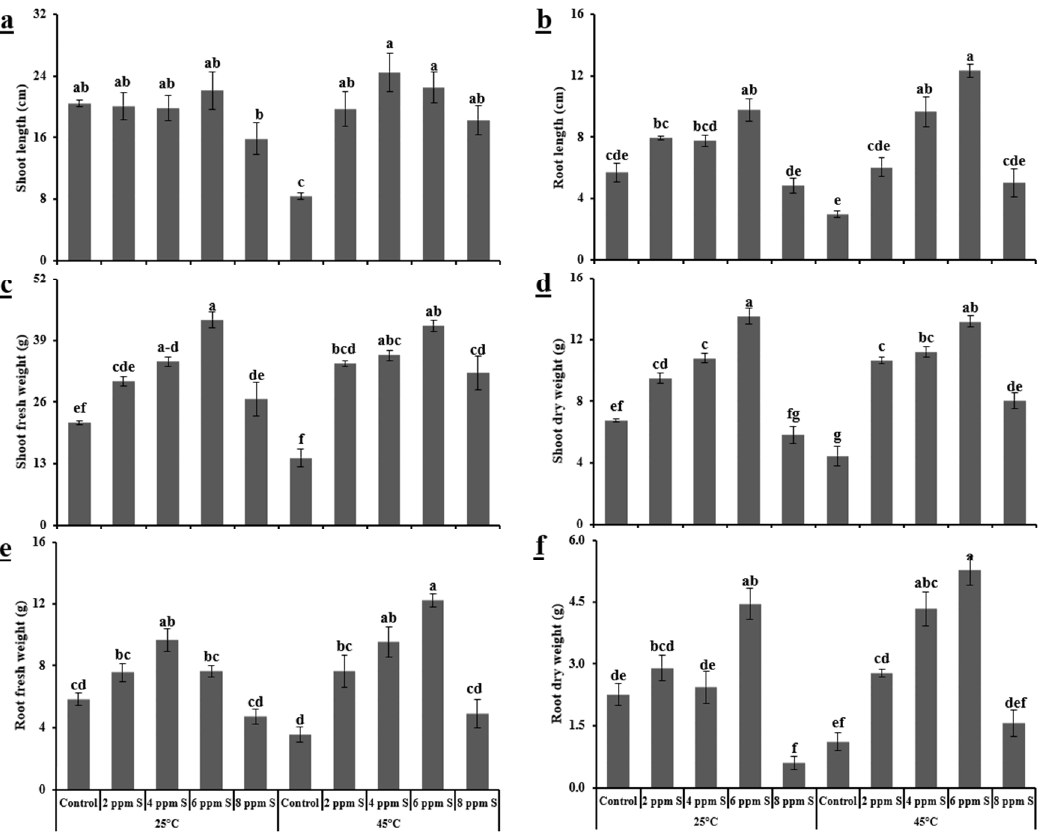
Figure 5. Morphological variables [i.e., shoot length ( a ), root length ( b ), shoot fresh weight ( c ), shoot dry weight ( d ), root fresh weight ( e ), root dry weight ( f )] of tomato plants (cv. Ahmar) as affected by temperature and exogenous application of S. Same letters indicate non-significant differences among treatments according to Tukey’s honestly significant difference test ( p ≤ 0.05). Vertical bars indicate averages ± standard errors ( n = 4, 5 plants per replicate).